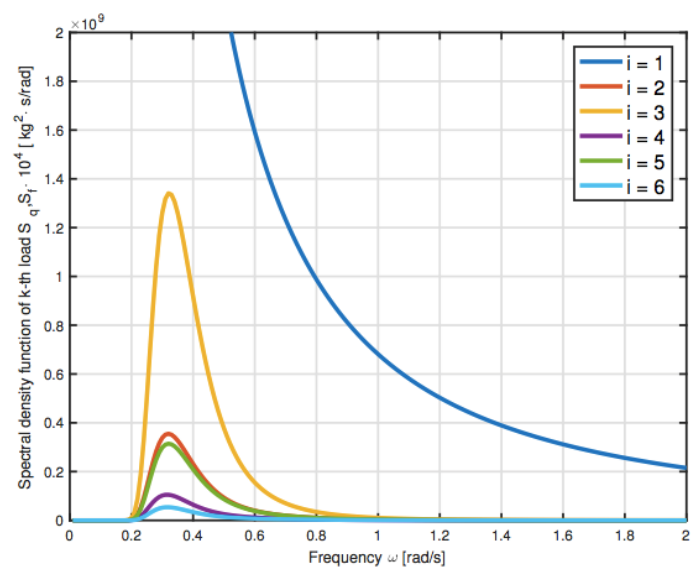
Figure 16. Crown pile spectral density of the generic environmental load in modal coordinates.